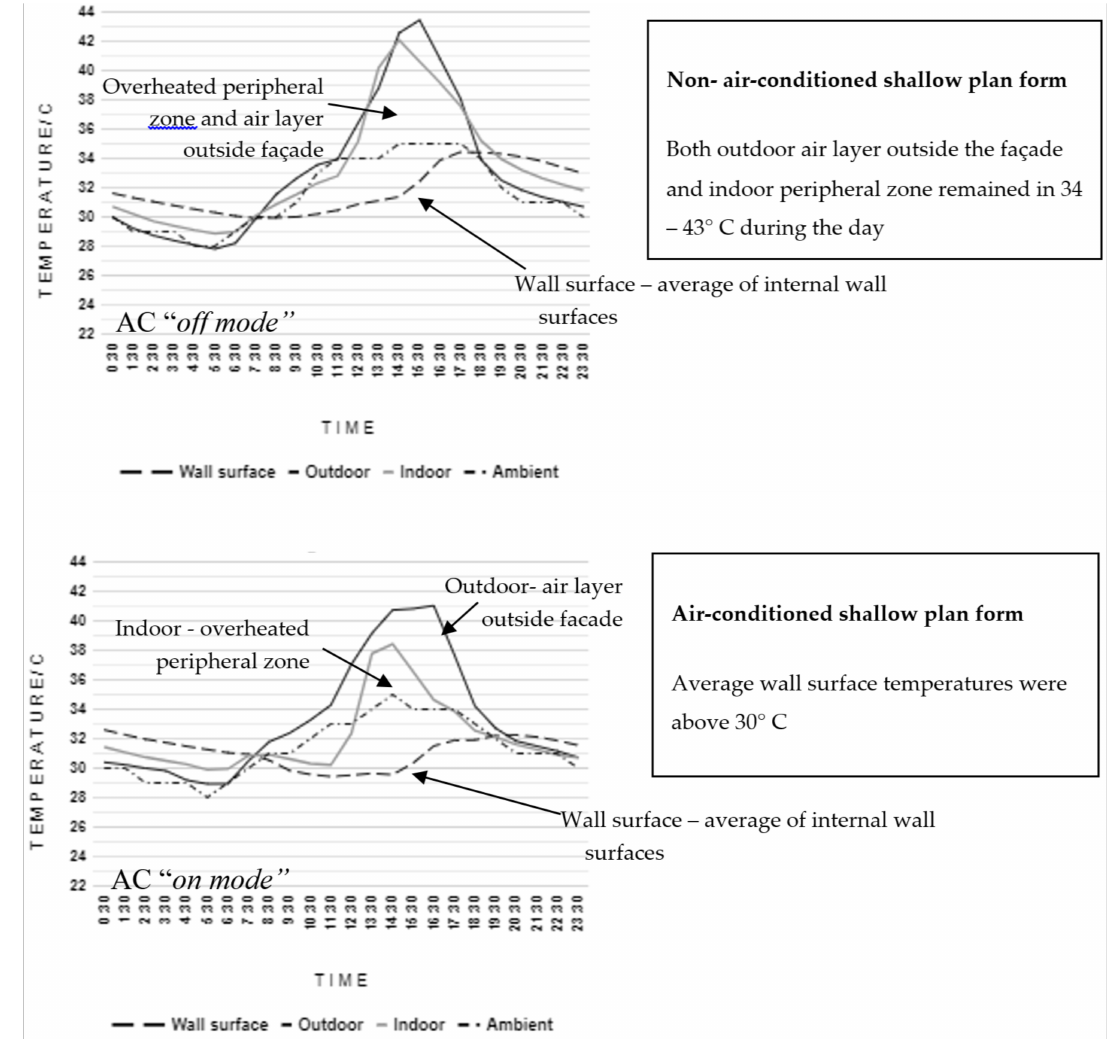
Figure 5. Indoor overheating in Building A with surface temperature behavior of façades and